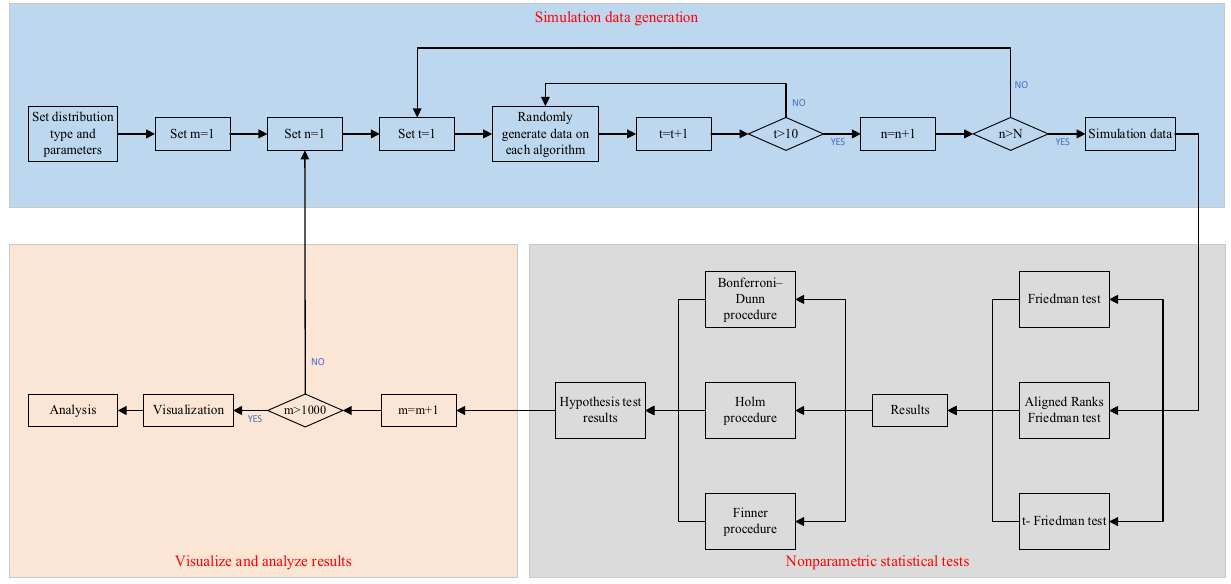
Fig. 3 Experimental flowchart adopted in this work